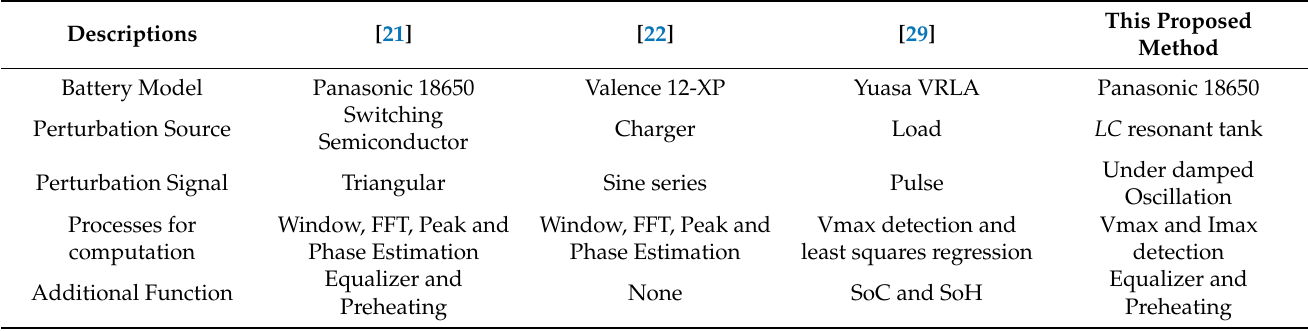
Table 4. Comparison of this proposed method with other